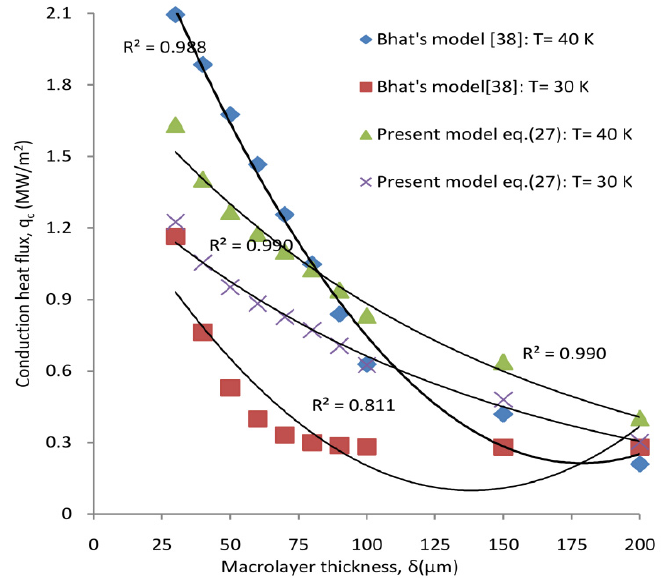
Figure 13. Relative dependence of the conduction heat fluxes on the macrolayer thickness at di ff erent superheats (t = 10 ms).